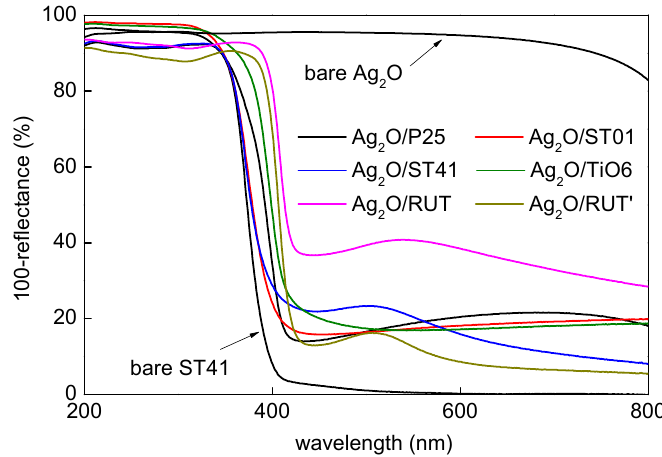
Figure 3. Diffuse reflectance spectra of Ag 2 O/TiO 2 samples.